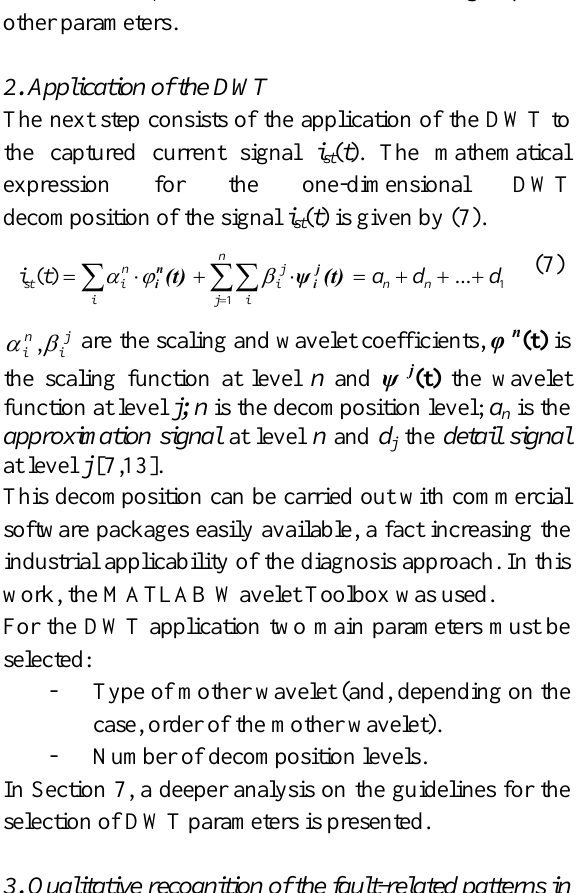
algorithm and the Nyquist criterion, a sampling frequency f around 5000 samples/second is enough, s